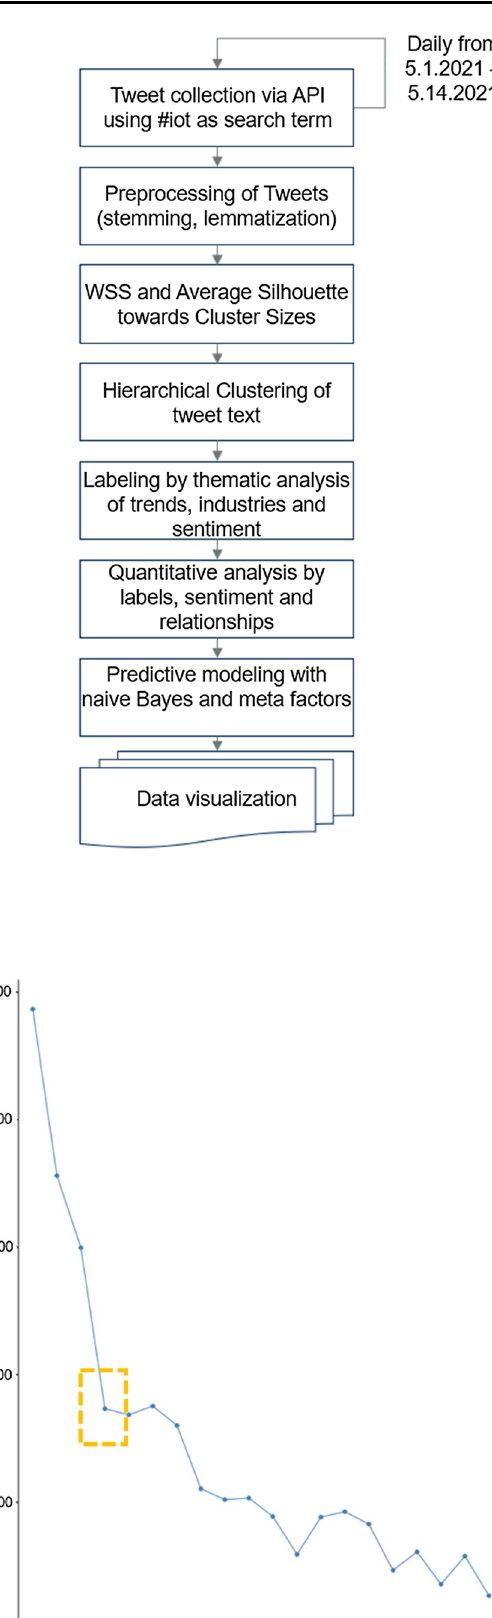
Fig. 1 Seven steps make up the methodology starting with an iterative collection of tweets through labeling and analysis until the visualization of the data